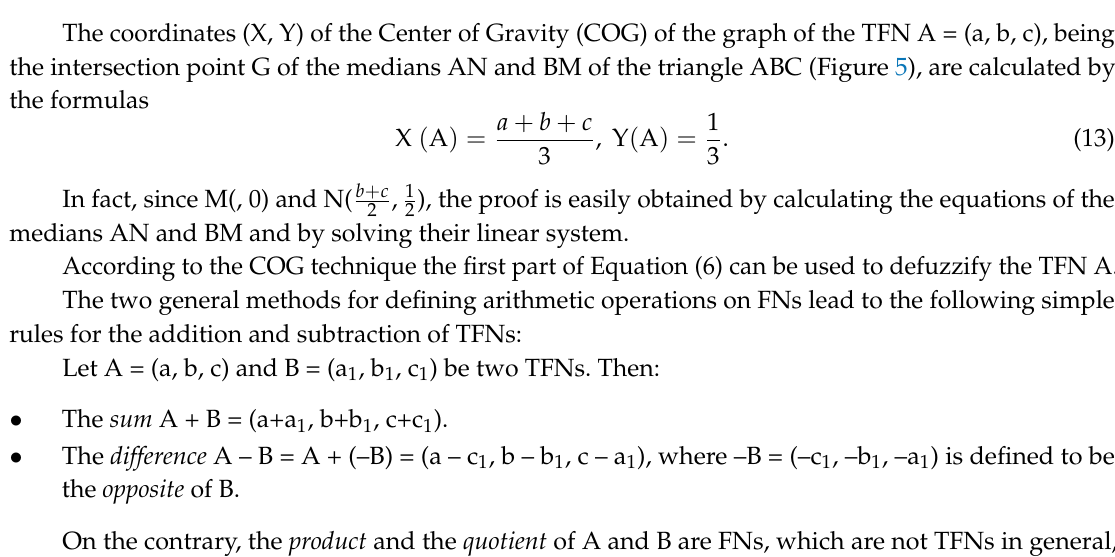
Figure 5. Graph and COG of the TFN (a, b, c).